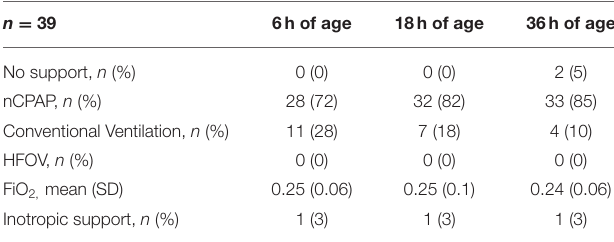
Standard Method Standard Method TOST Equivalency p (for raw bounds − 20 to + 20 mL/kg/min (90% Mean (SD); Median (IQR) Mean (SD); Median (IQR) Confidence